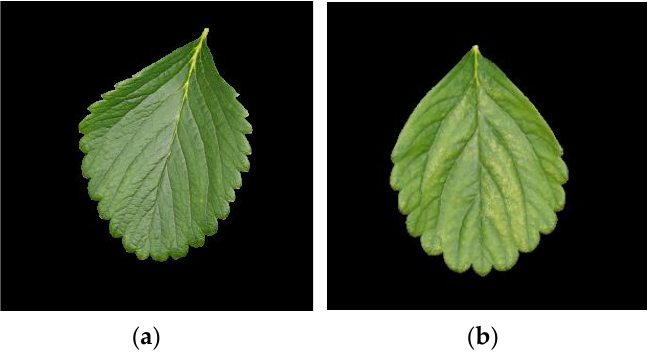
Figure 4. ( a ) Normal and ( b ) colored segmented strawberry leaf images for RGB mean extraction under different soil physicochemical conditions.